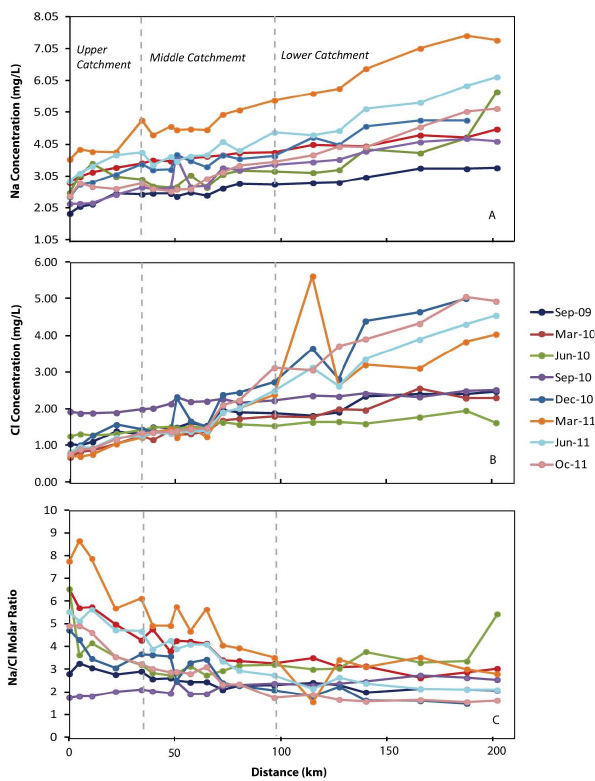
Fig. 5. Variation in Na (A) and Cl (B) concentrations, and Na/Cl ra- tios (C) along the river. Na and Cl concentrations increase progres- sively downstream, whereas the Na/Cl ratios decrease